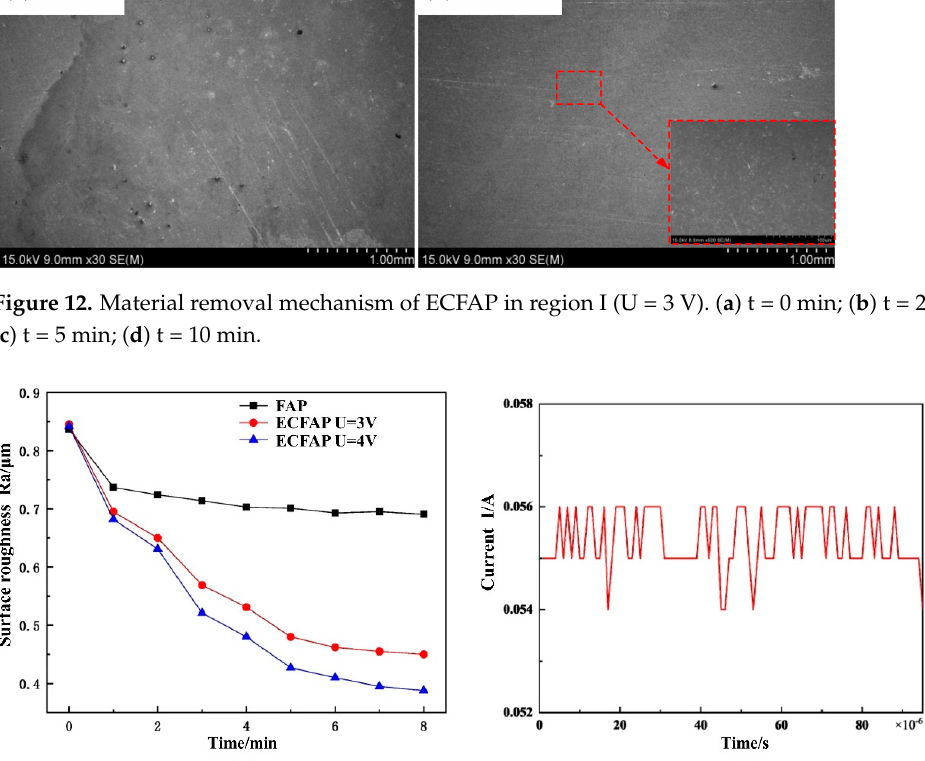
Figure 12. Material removal mechanism of ECFAP in region I (U = 3 V). ( a ) t = 0 min; ( b ) t = 2 min; ( c ) t = 5 min; ( a ) t = 10 min.